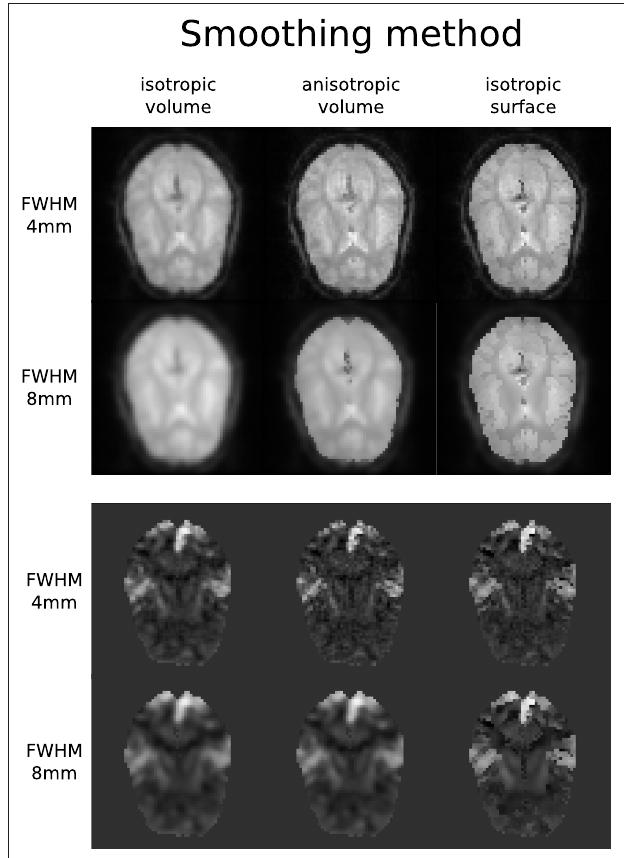
FiGure 7 | influence of different smoothing methods and their parameters. Upper half shows direct influence of smoothing on the EPI sequence (slice 16, volume 0, run 2). Lower half shows indirect influence of smoothing on the T maps (same slice) of the main